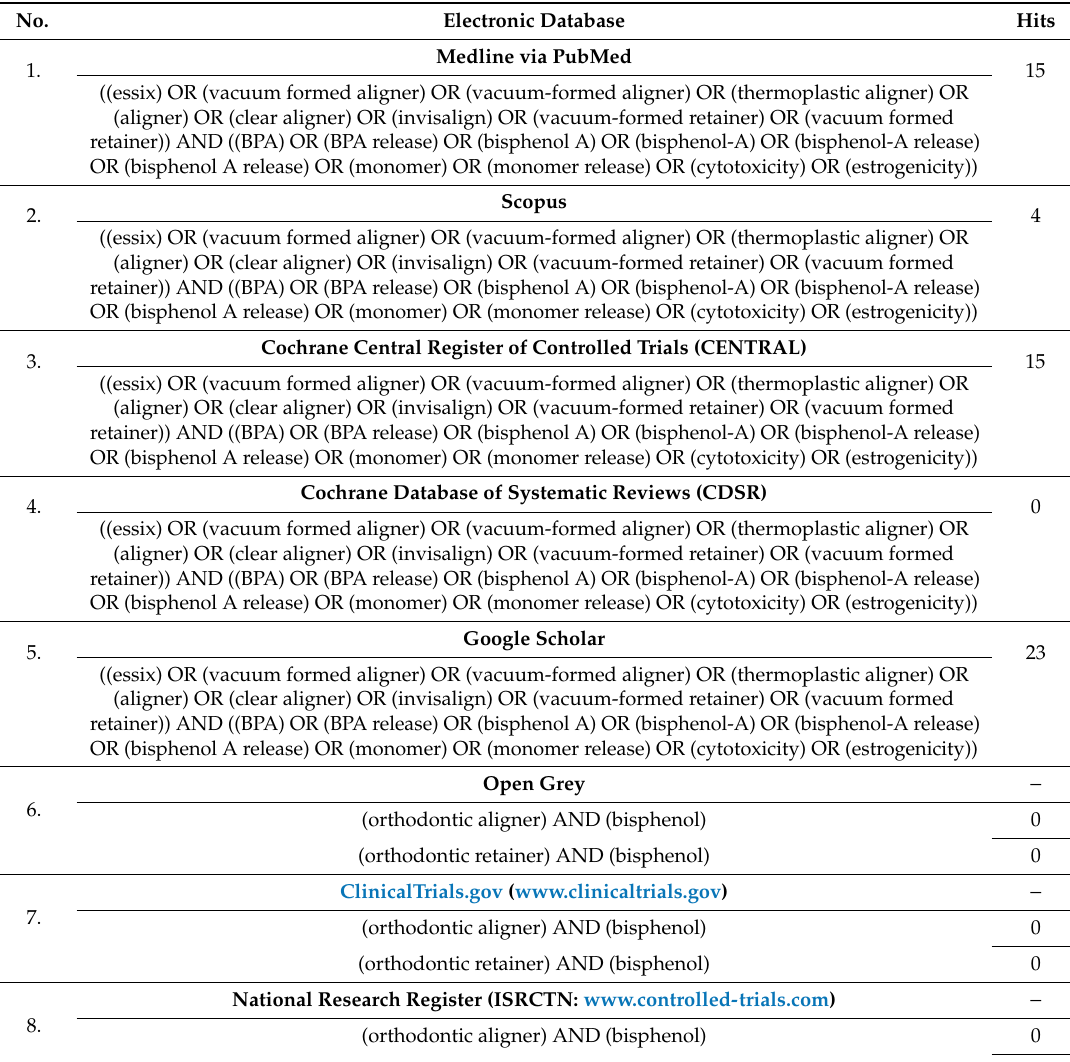
Table A1. Search strategy for study selection across